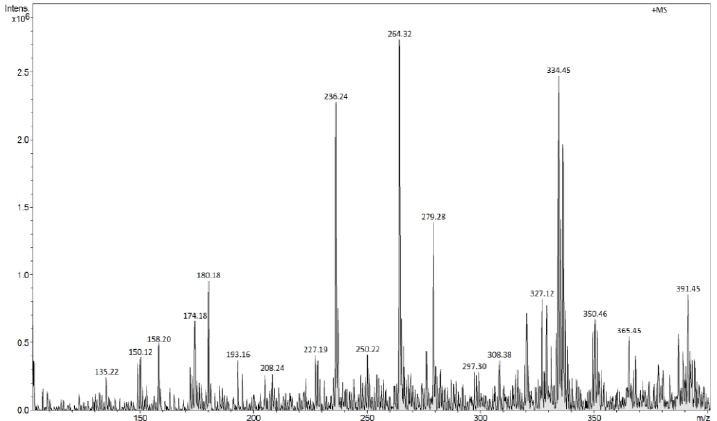
Figure 5. FAPA-MS spectrum of MIP in the range of positive ions.